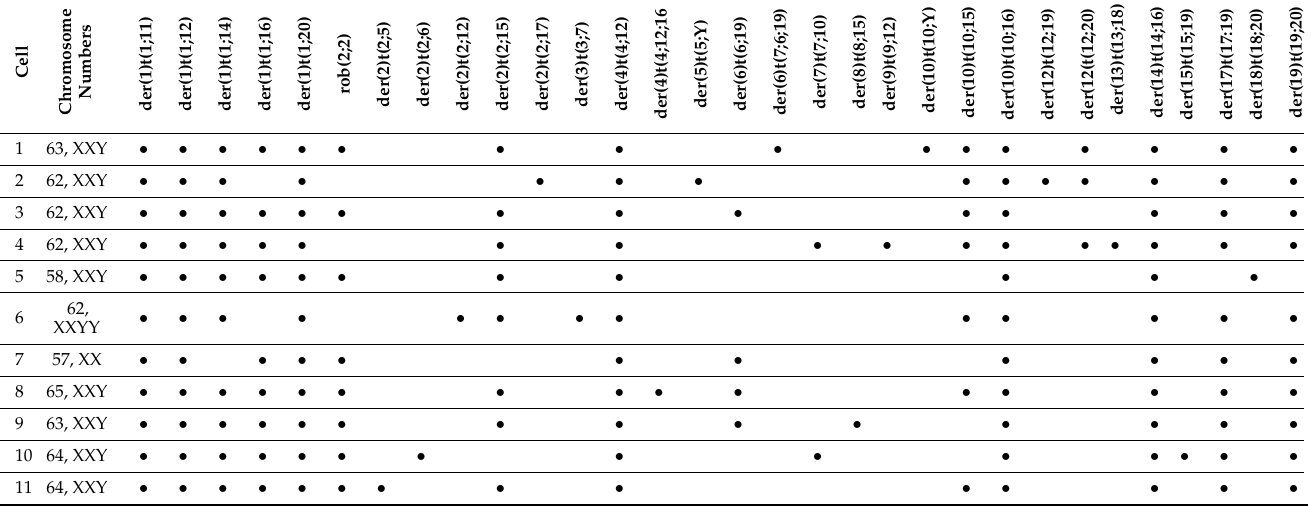
Table 3. Common and sporadic structural chromosomal aberrations ( • ) in CFSC-2G identified through spectral karyotyping.